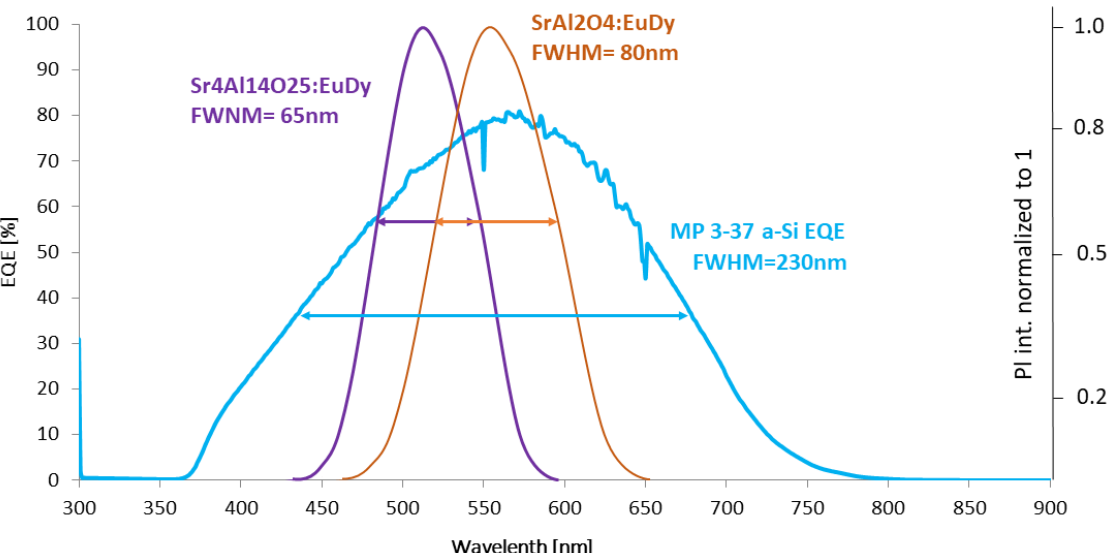
Figure 5. EQE characteristics of commercially available, flexible a-Si solar cells (MP3–37) and luminescent layer emission spectrums normalized to 1 for Sr 4 Al 14 O 25 : Eu, Dy and SrAl 2 O 4 : Eu, and Dy with FWHM of each characteristic [77].